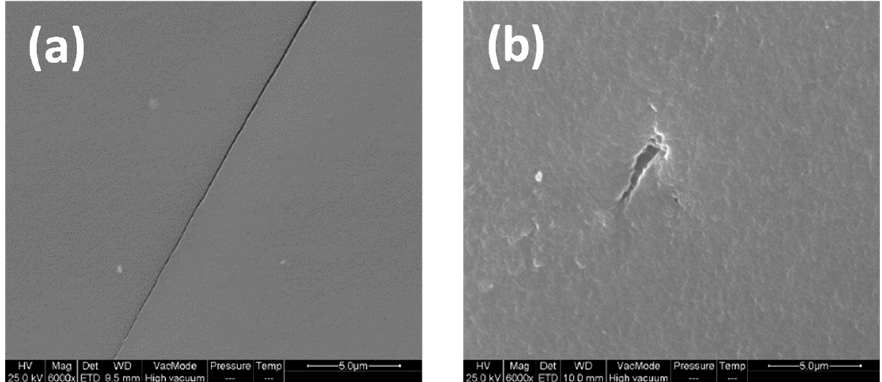
/ PCL 2 gel and ( b ) TiO 2 6 wt.%